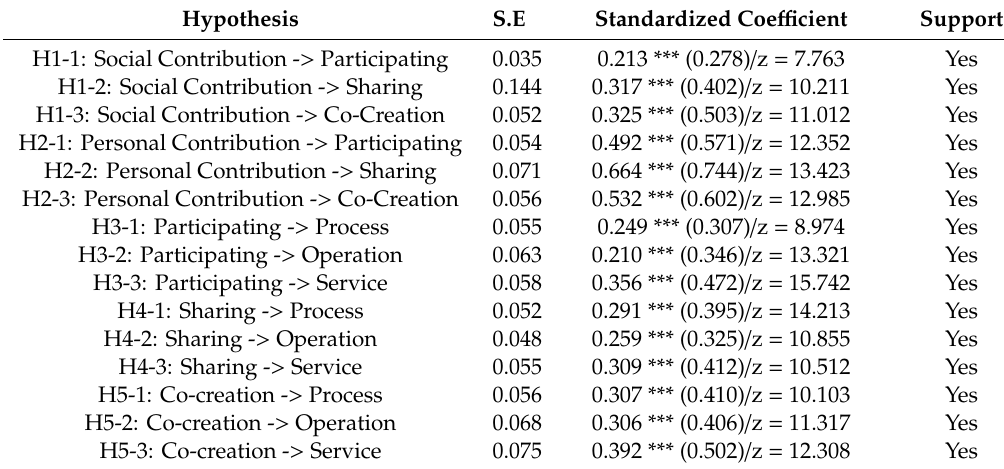
Table 6. Summary of hypothesis tests.